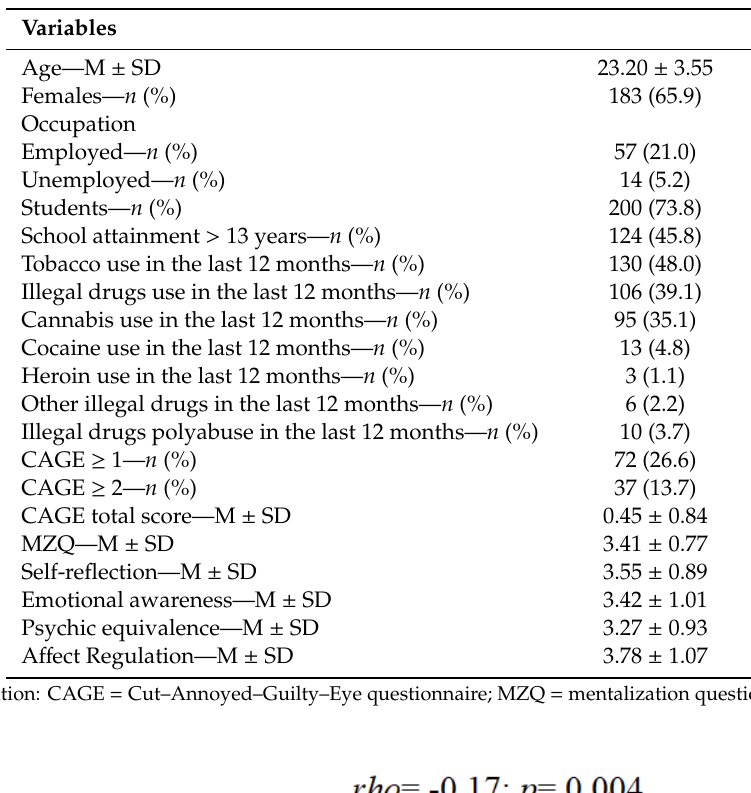
Table 1. Descriptive statistics for the sample ( n = 271).